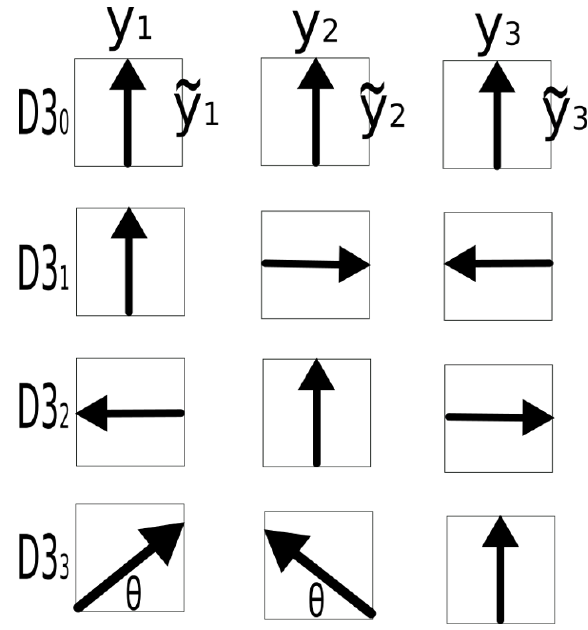
Figure 1 . D3-brane con(cid:12)guration in the internal